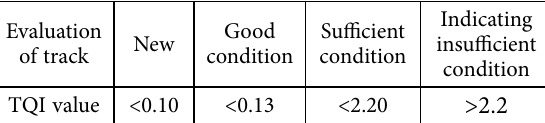
Table 5. Track quality qualifications of railway tracks by TQI coefficient Evaluation of